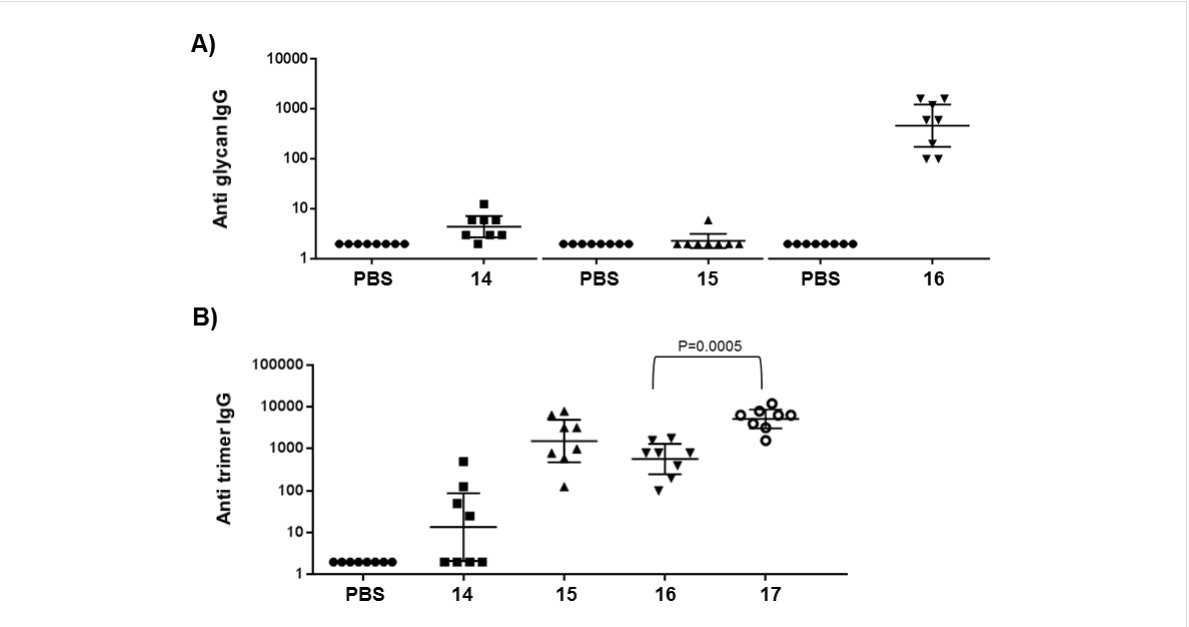
Figure 3: A) IgG levels detected at OD = 1 in individual post 3 sera of BALB/c mice immunization at 0.3 μ g saccharide dose of antigen. A) Sera from conjugates 14 , 15 and 16 were tested against the monomer-, dimer- and trimer-HSA conjugate, respectively, presenting different linker and protein (see Supporting Information File 1). B) Comparison of anti trimer-HSA antibody levels in sera from conjugates 14 – 17 . Each point represents indi- vidual mouse sera; horizontal bars indicate geometric mean titers (GMT) of each group with 95% statistical confidence intervals indicated by upper and lower bars.